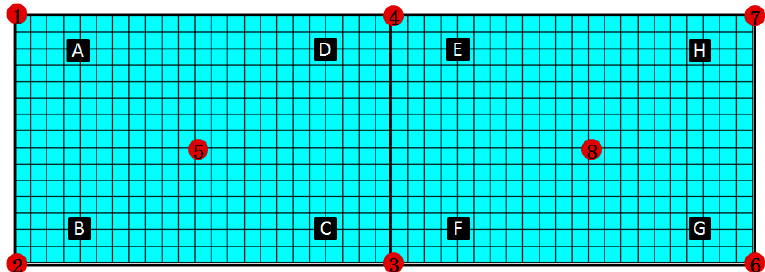
Figure 2. Inverse finite elements model of structure.